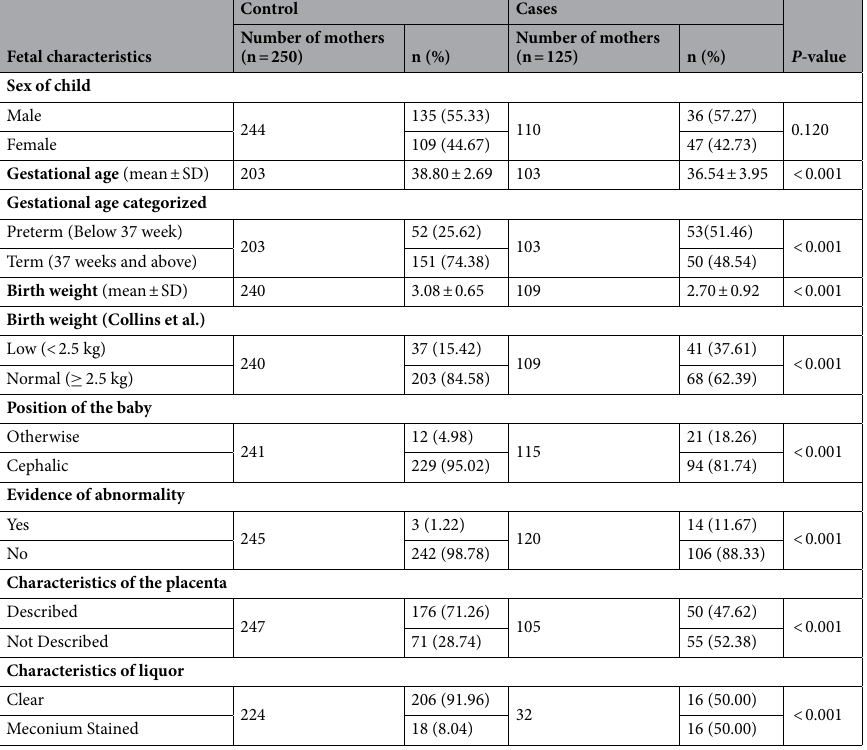
Table 2. Fetal factors associated with intrapartum stillbirth in six public hospitals in 2016. SD Standard Deviation. (%) represent column percentage, n Total number of cases and controls that were actually used in the estimation of the test